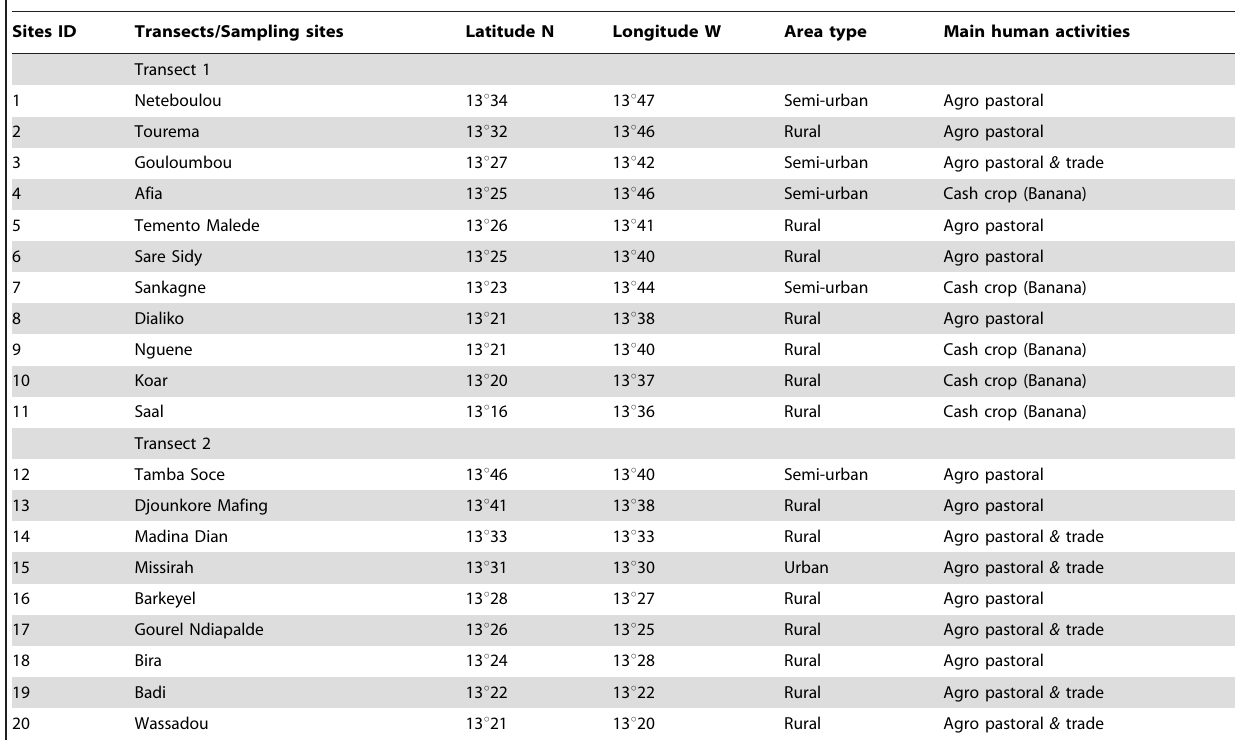
Table 1. Main characteristics of the study sites.